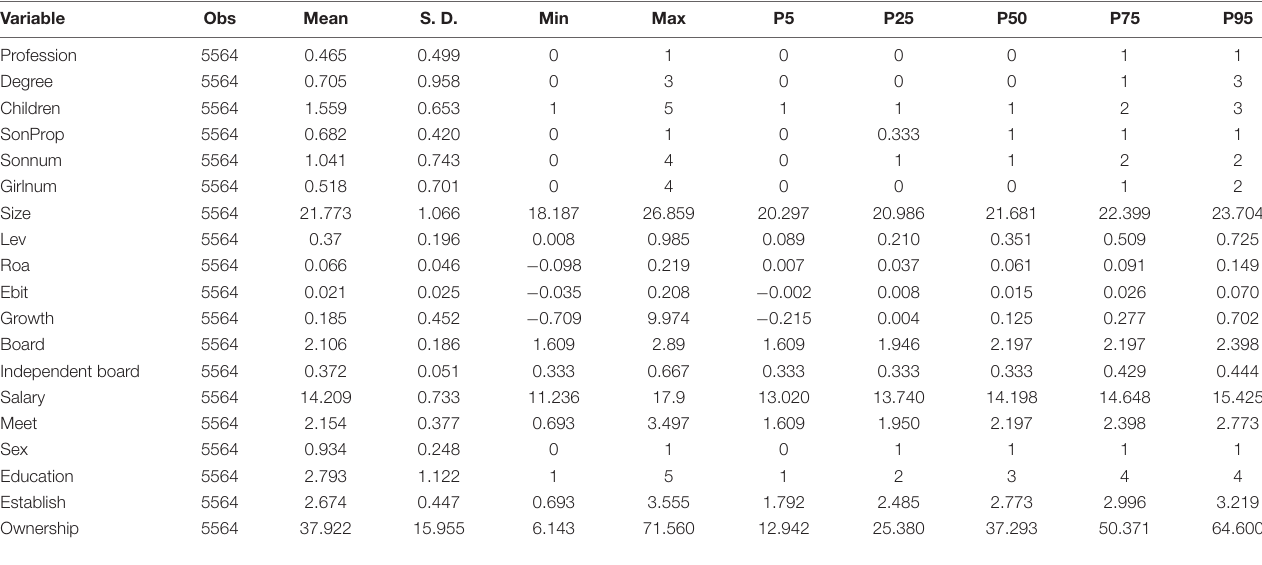
TABLE 2 | Descriptive